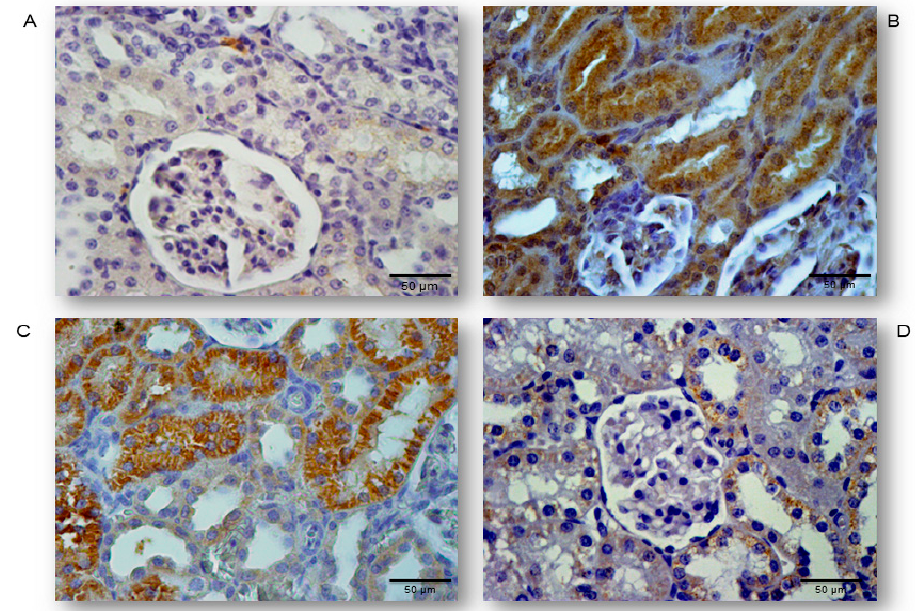
Figure 2. Representative images of apoptotic renal tubular epithelial cells that were challenged